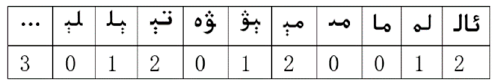
Figure 8. SHIFT table for Wu–Manber–Uy.